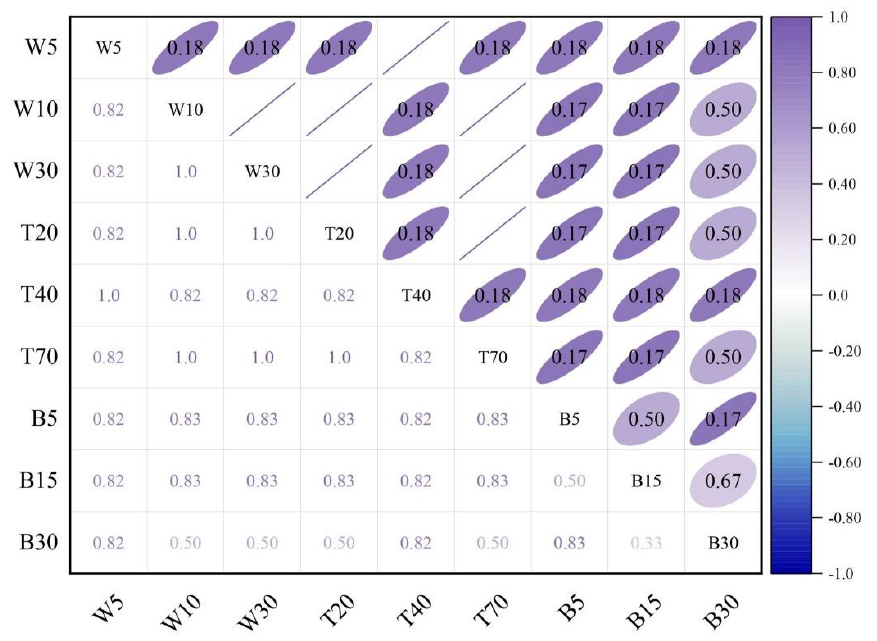
Figure 11. The Spearman’s rank correlation coefficient of landscape elements based on PET.